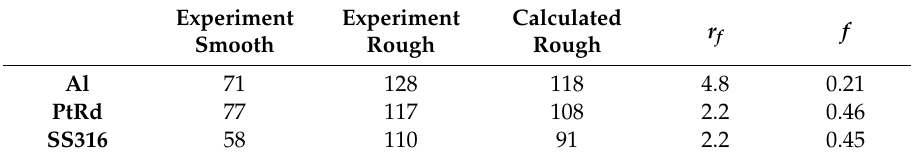
Table 2. Experimental and calculated values of the contact angles on the surfaces of di ff erent crucibles.